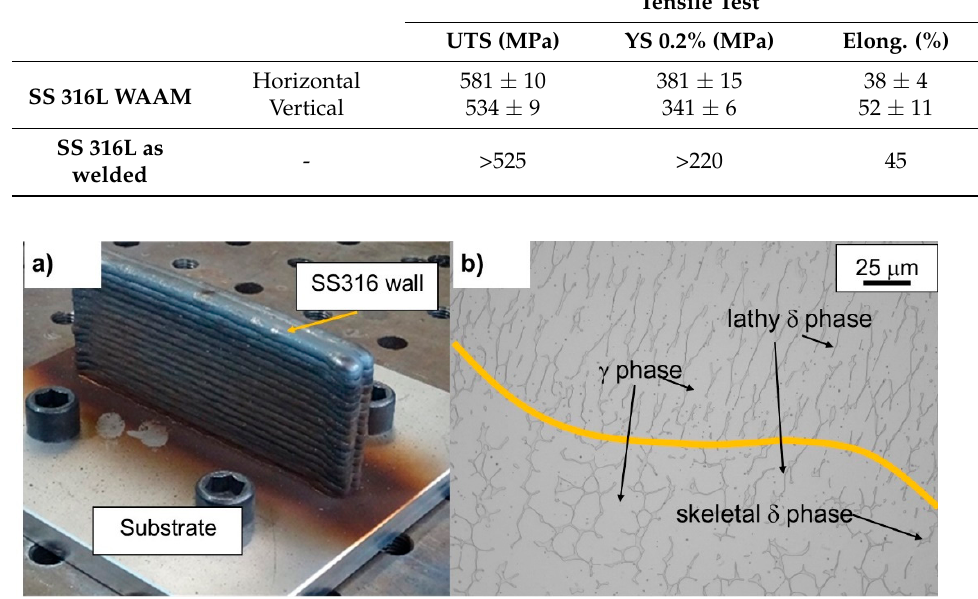
Figure 5. ( a ) Double wall manufactured by PAW with SS 316L-Si. ( b ) Microstructure of the interface zone.